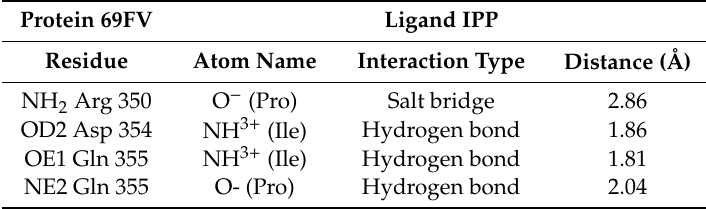
Figure 5. Docking results of the peptide LVYPFP in the human ACE active site. LVYPFP is represented in red, the interactions of human ACE residues with the peptide are indicated by arrows of di ff erent colours with purple representing hydrogen bond interactions, and blue arrows representing salt bridge interactions. The software Maestro was used for the generation of this figure. Table 1. IPP docking results.